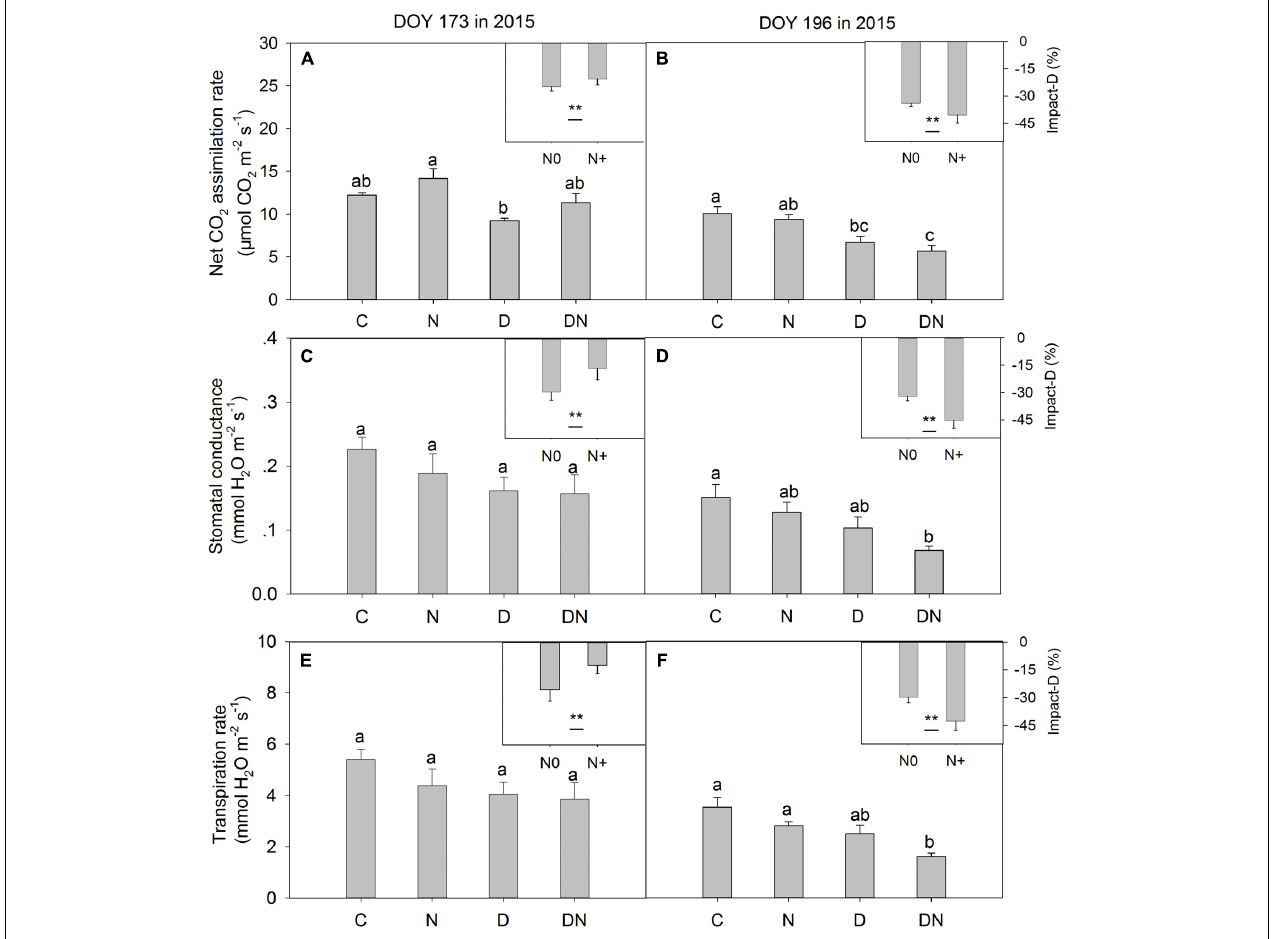
FIGURE 2 | Responses of leaf gas exchange parameters [ (A,B) net CO 2 assimilation rate, (C,D) stomatal conductance and (E,F) transpiration rate] in Leymus chinensis to four treatments (C, control; N, nitrogen addition; D, drought; DN, nitrogen addition plus drought) at the middle (DOY 173) and the end (DOY 196) of the drought period. Impact-D = ( X D – X C )/ X C × 100, or = ( X DN – X N )/ X N × 100, where X indicates net CO 2 assimilation rate, stomatal conductance, or transpiration rate. Different letters and asterisk indicate significant differences between the treatments ( P < 0.05). The error bars represent standard errors of means ( n =